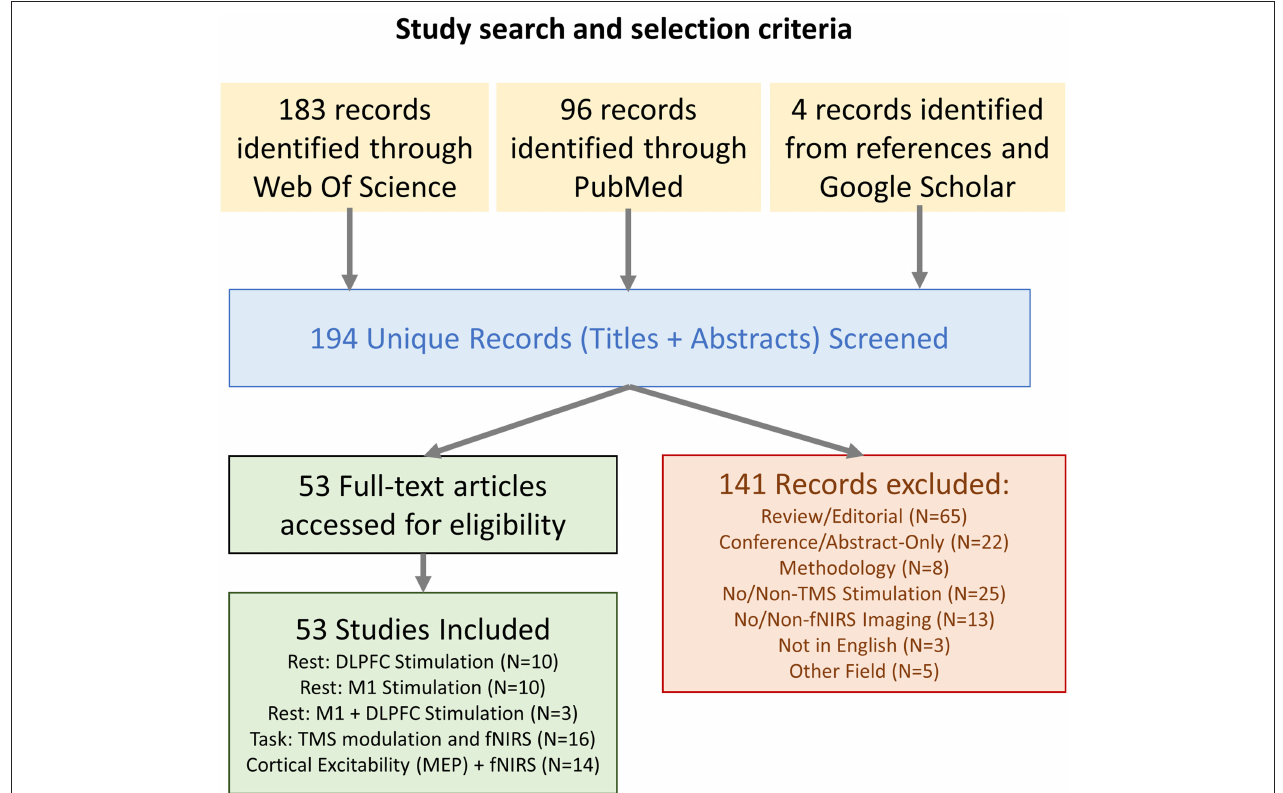
FIGURE 1 | Flow chart describing the study selection. estimation of RMT using the conversion factor (100%RMT = 140%AMT) and noted using a tilde ( ∼ ) where this estimation has been